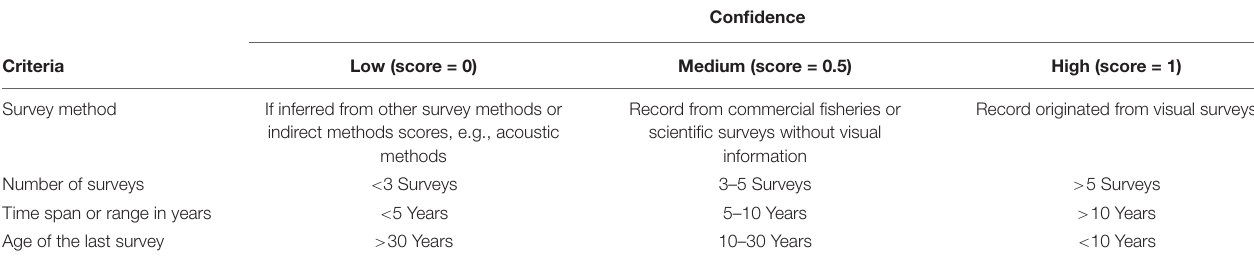
TABLE 2 | Criteria used to score different components of the “Confidence index” for each grid cell.